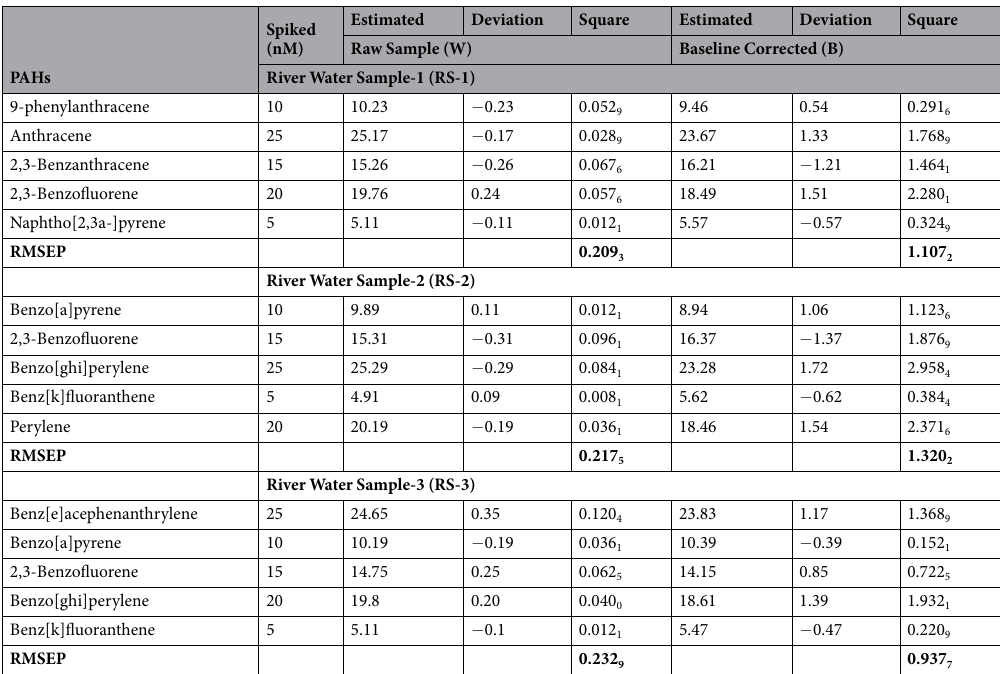
Table 2. Root mean square error in prediction (RMSEP) of the analyte composition in the river water samples